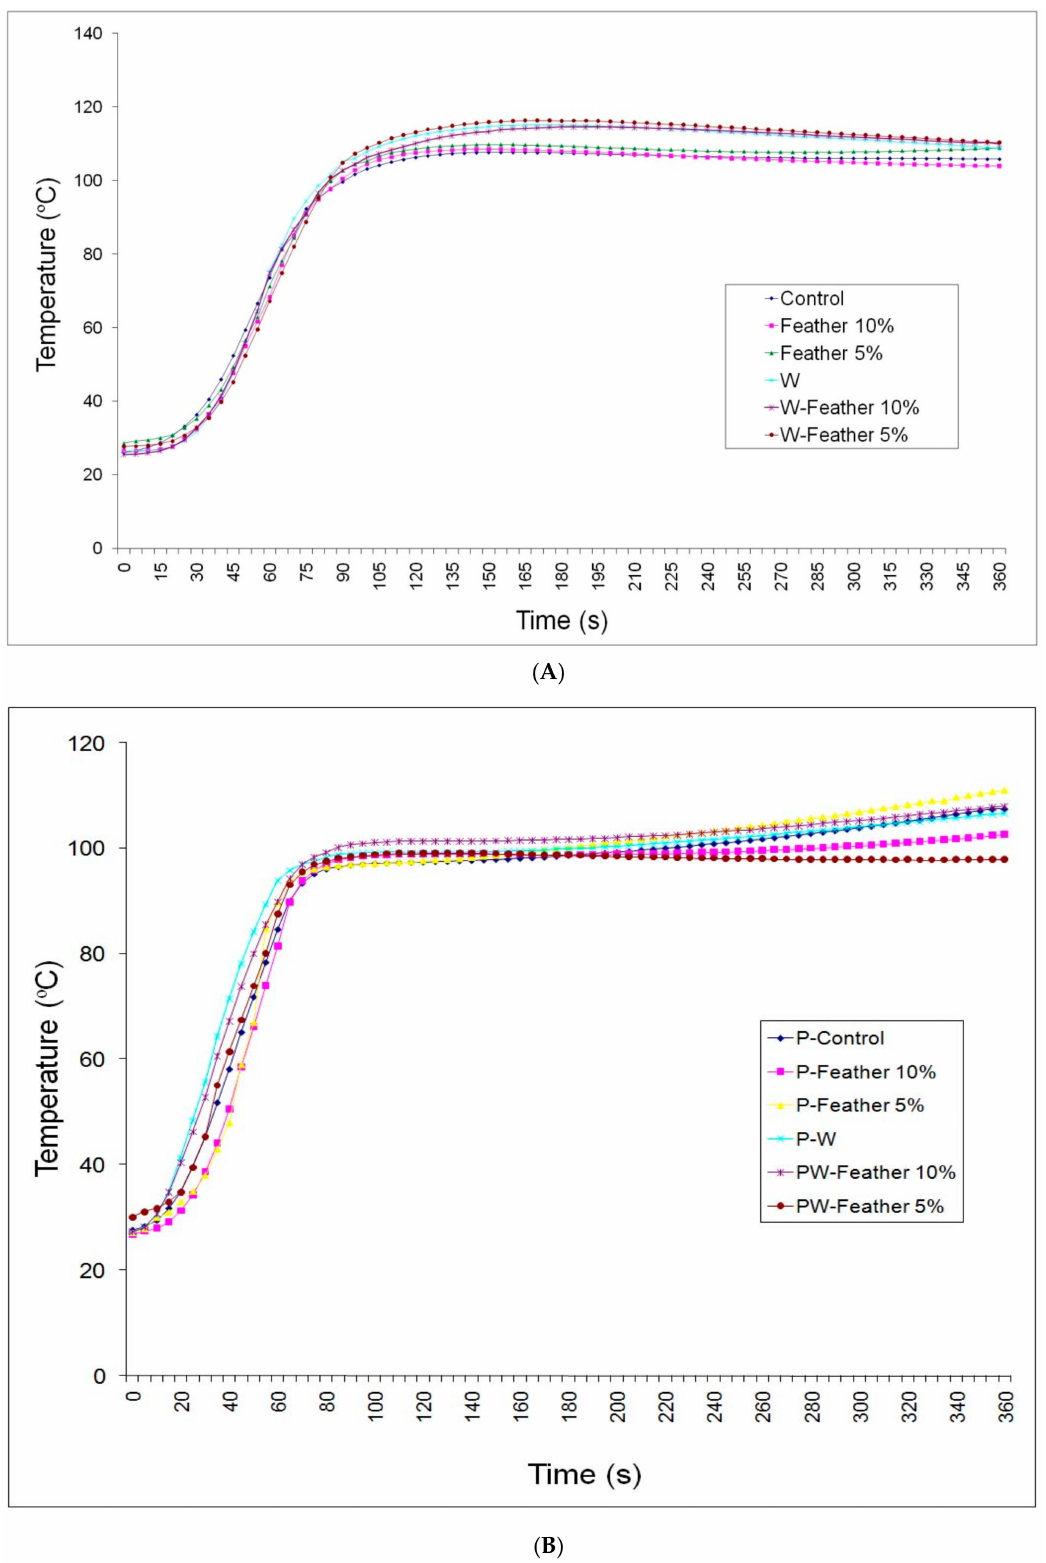
Figure 2. Temperature (Celsius) at the core section of the MDF ( A ), and the particleboard ( B ) at 5-s intervals (P = particleboard; MDF = medium-density fiberboard; W = wollastonite; S = time